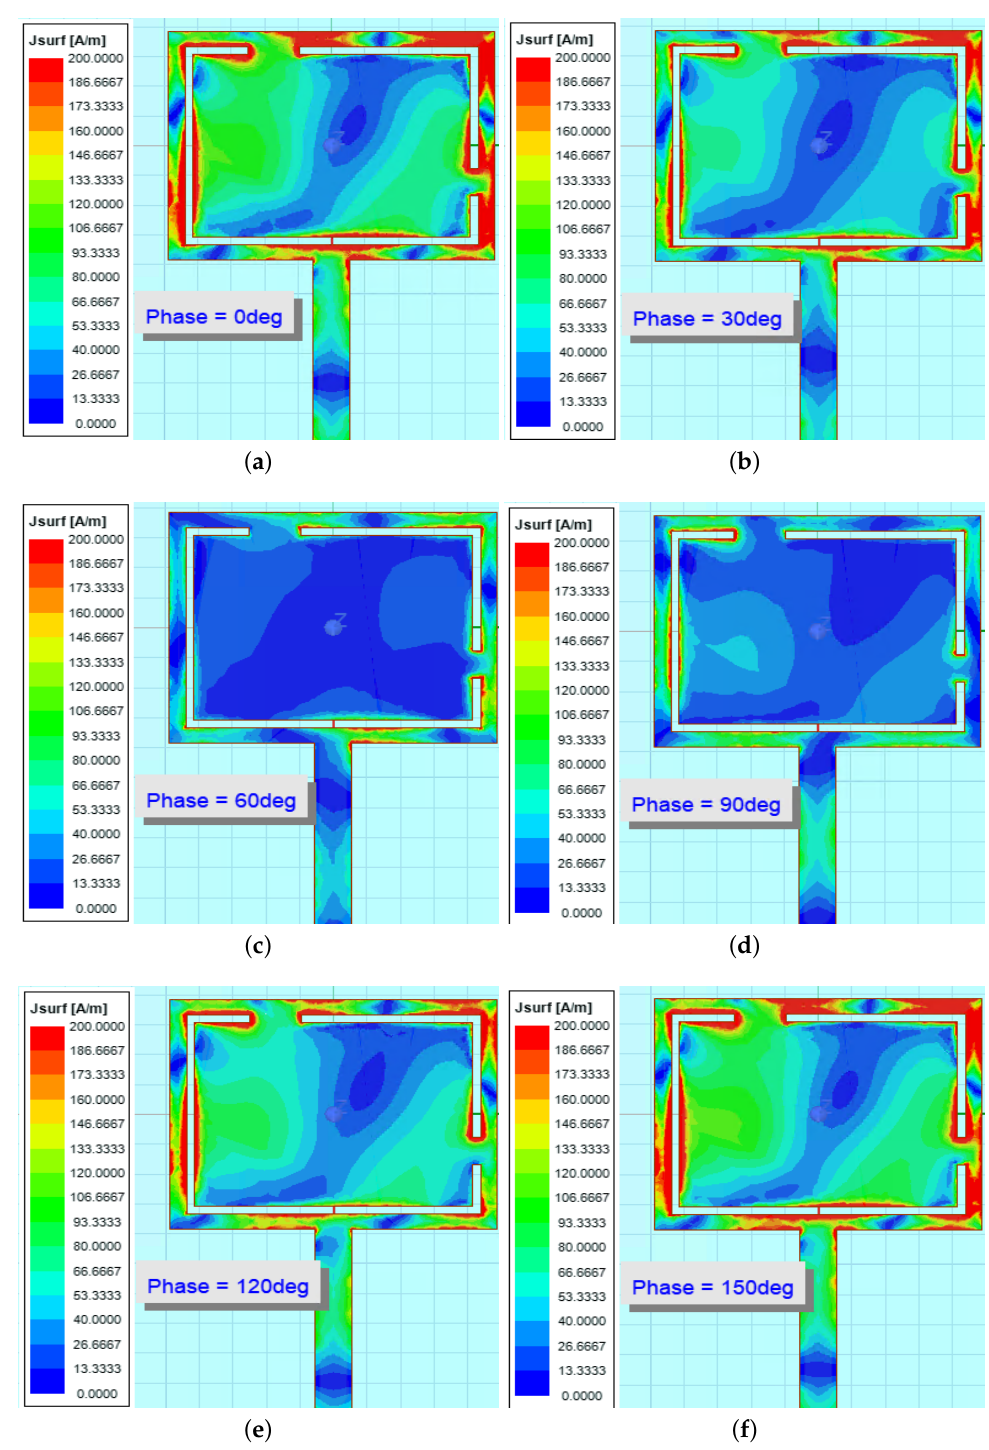
Figure 18. Surface current distribution at 8.4 GHz for cylinder radius of 50 mm. ( a ) 0